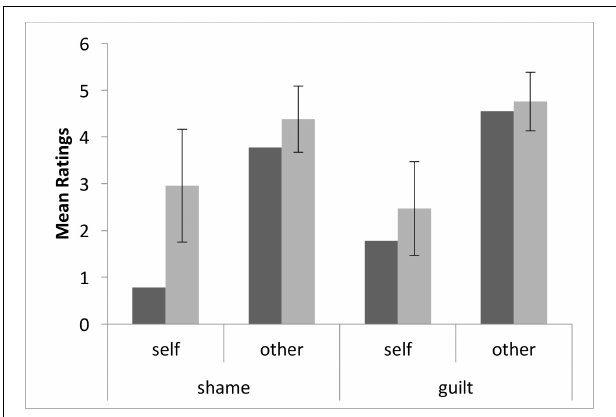
FIGURE 2 | Patient’s (dark gray) and healthy controls’ (light gray) scores on the SGT. The error bars indicate standard deviations.